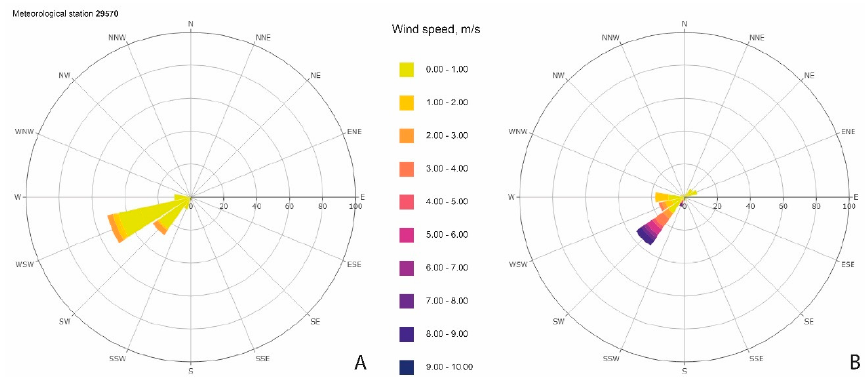
Figure 9. Simulated ( A ) and measured ( B ) wind flows and speeds distribution for meteorological station code 29570.